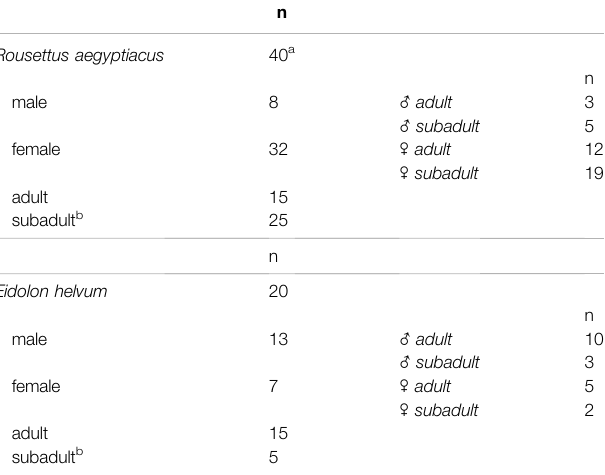
TABLE 1 | Number of animals included in the